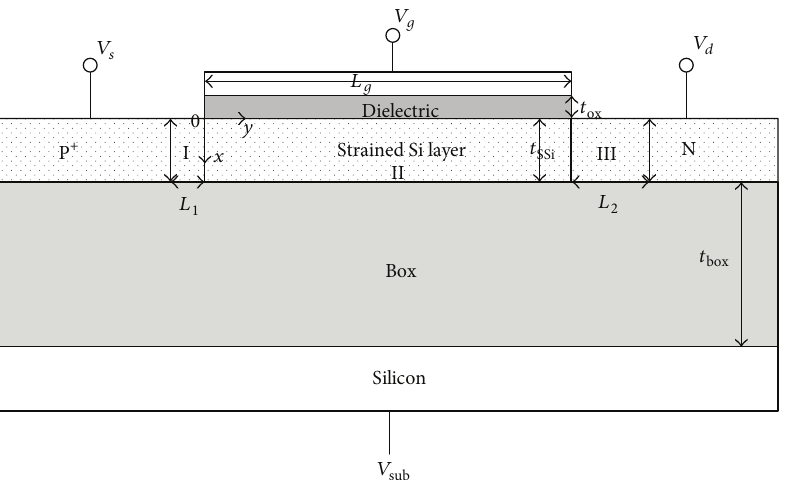
Figure 1: Schematic representation of the FD-SSOI N-TFET used in this paper. Poisson’s equation is solved on the three regions I, II, and III, corresponding to the depletion regions induced by the junctions inside the source and drain (I and III) and the intrinsic region (II).